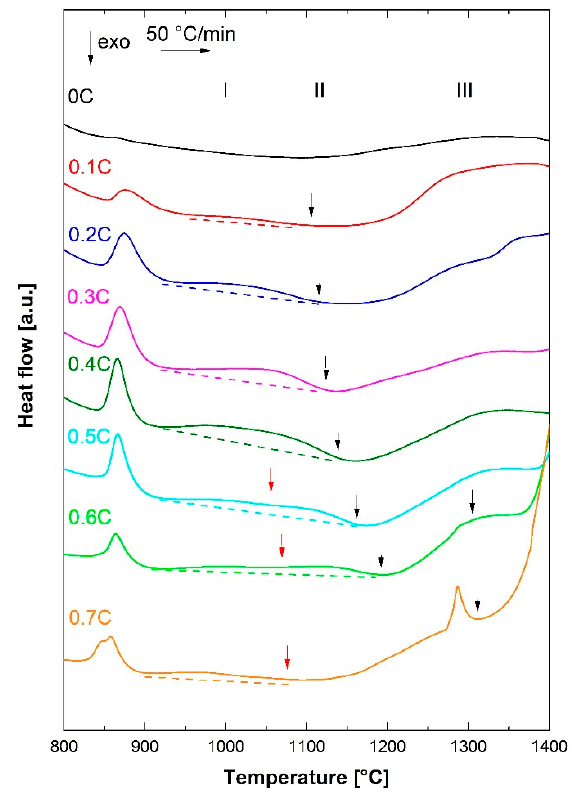
Figure 5. DSC results during heating for the interpretation of the precipitation reactions. For the meaning of arrows, see body text.